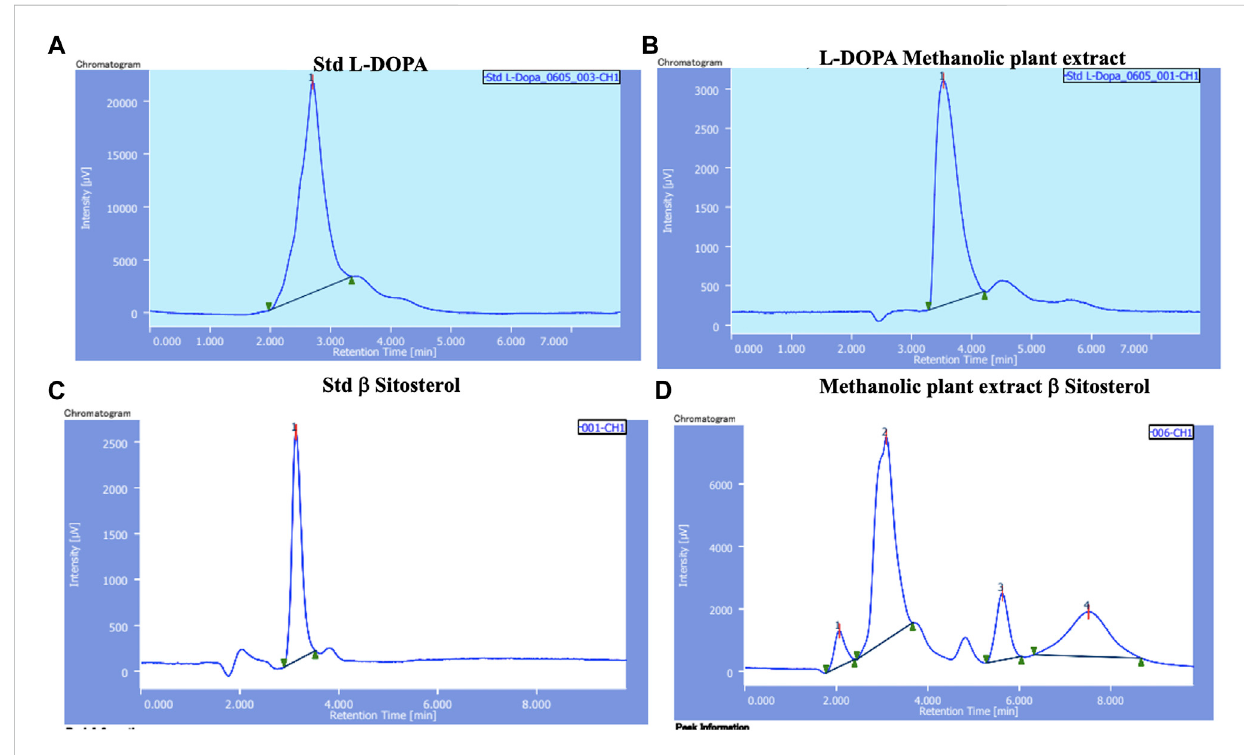
FIGURE 1 HPLC chromatograms of (A) L-DOPA standard; (B) L-DOPA from methanol extract of M. pruriens seed; (C) β -sitosterol standard; (D) β -sitosterol from methanol extract of M. pruriens seed.